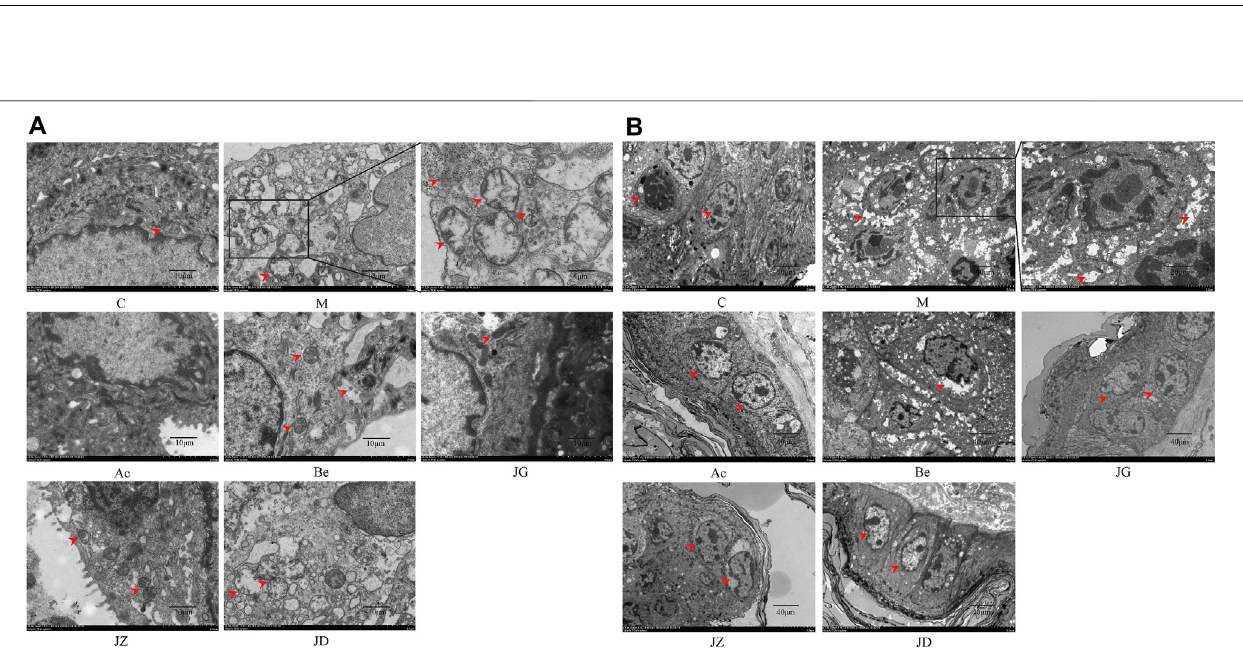
Frontiers in Pharmacology |